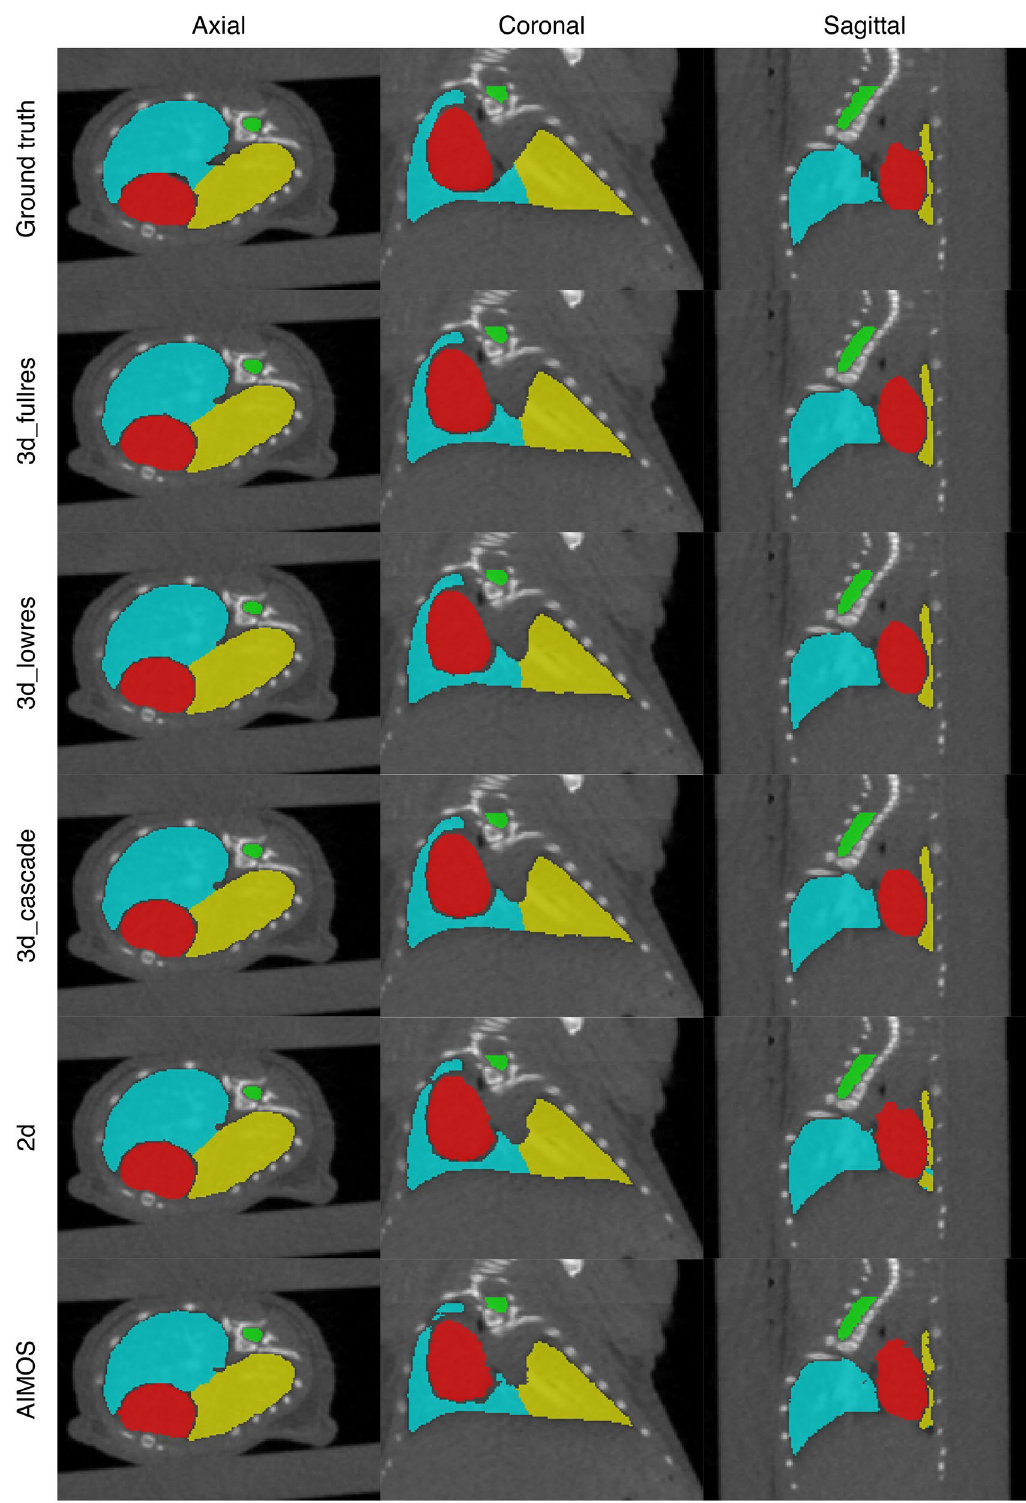
Figure 1. An example segmentation in the axial, coronal and sagittal views for test set 1. The first row shows the manual contours of observer 1 while the succeeding rows are the automated contours generated by each model. Contours in red, green, blue and yellow correspond to the heart, spinal cord, right lung and left lung,